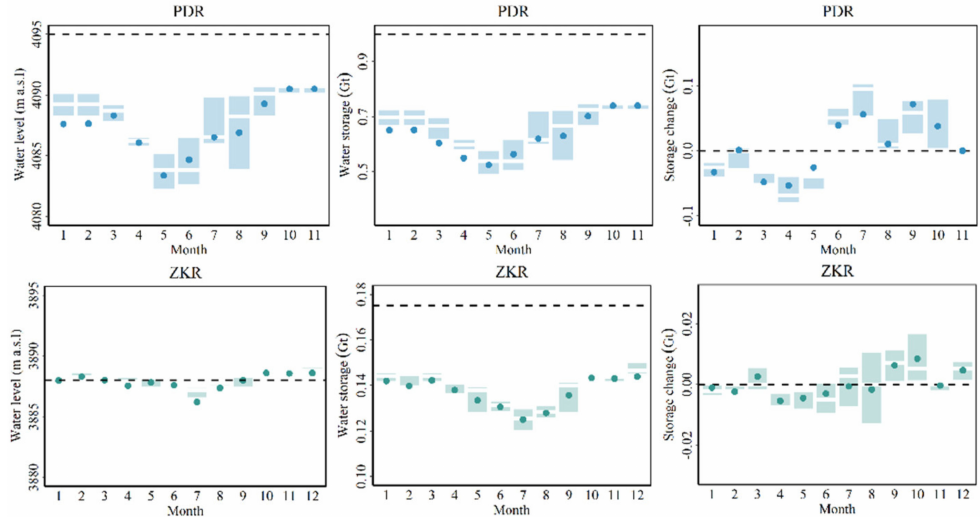
Figure 3. Multiyear averaged monthly water level, storage, and storage change of the PDR (2014– 2018) and the ZKR (2007–2018), respectively. The dashed lines of the water level and water storage are the designed normal water level and the corresponding water storage. The month of December for the PDR is omitted because of a lack of valid observations in the GSW